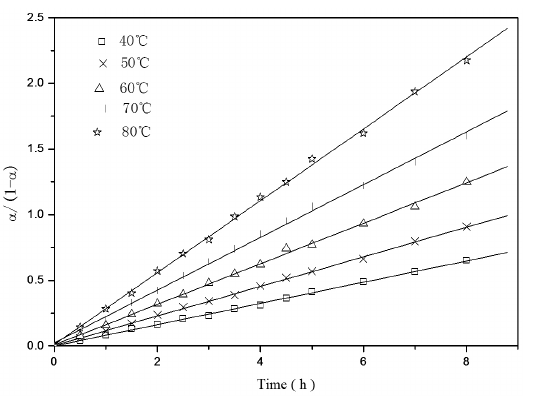
Figure 8. Plots of α /(1- α ) - t for control sample at different temperatures.